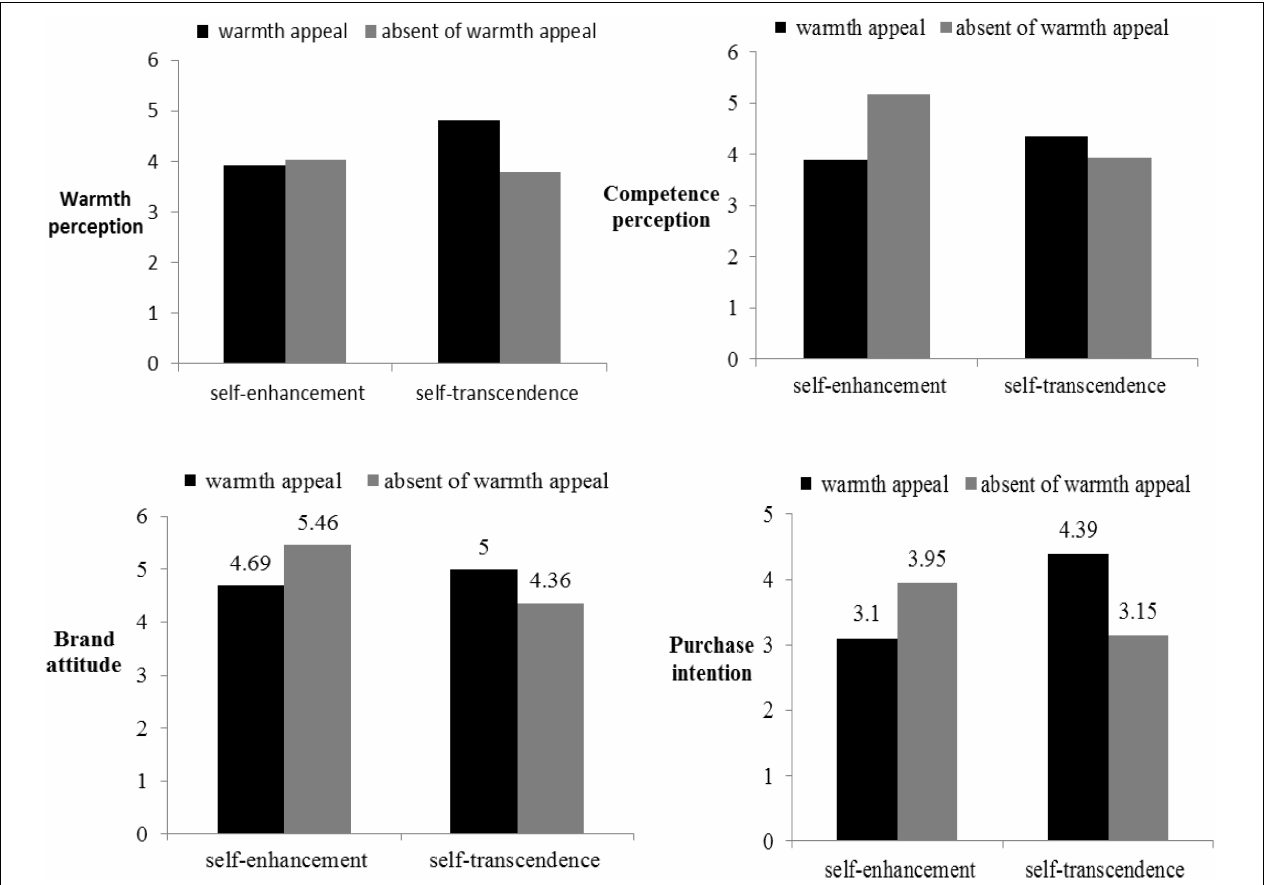
FIGURE 4 | Warmth perception, competence perception, brand attitudes and purchase intention in Experiment